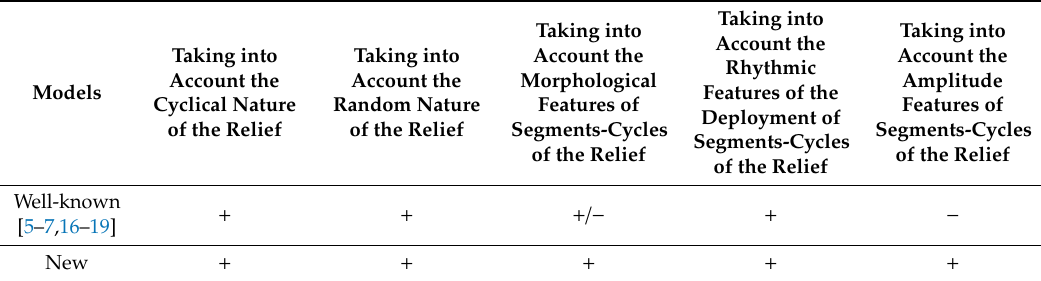
Table 1. Comparison of characteristics of the well-known and new mathematical models of the surface relief after laser